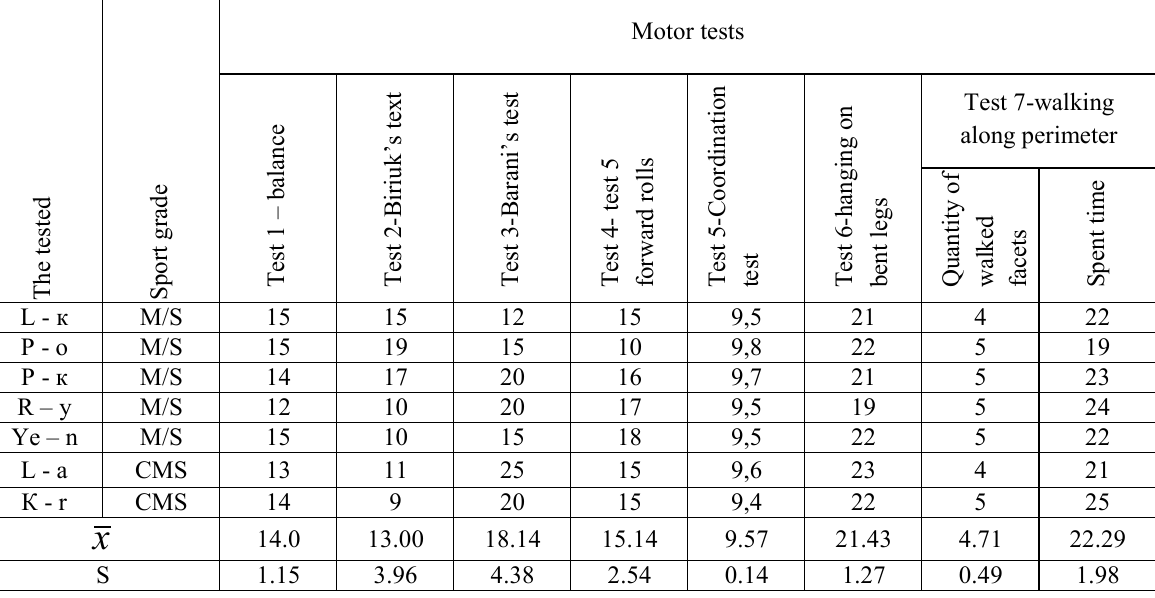
Initial indicators of sensor-motor coordination of first year students (NUPESU), specializing in sport gymnastic